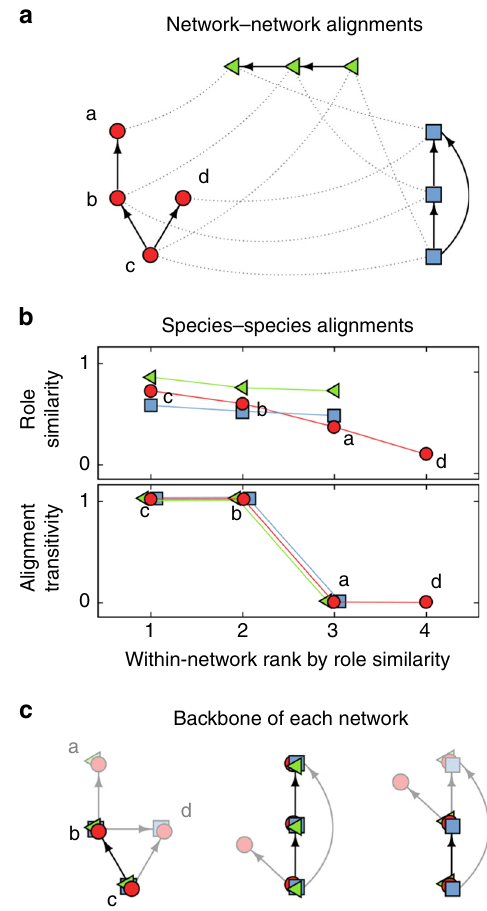
Fig. 1 Network alignment and identifying a backbone of interactions. a An example of the optimal alignments between three simple networks. The red circles, green triangles, and blue squares represent the species in each network, and the arrows indicate the direction of energy fl ow between those species. The dotted lines characterize the pairings of species in the three alignments between networks. b Given the alignments in a , we rank species according to the average role similarity that they present across their pairings. The top panel shows the actual average role similarity, and the bottom presents the alignment transitivity of those same species. The best-aligned species from the red network is species c , whereas the worst- aligned is species d . The species in the blue and green networks to which species c is paired are also paired, which implies that the alignment transitivity of c is 1. In contrast, the alignment transitivity for species d is 0 because there are no paired species in the blue and green networks to which d is paired. c Given the alignments in a , we can also identify the backbone of interactions for each network. Here, the dark links are those that present the maximum overlap across network alignments and therefore characterize the backbone of interactions. The lighter links represent the periphery of such